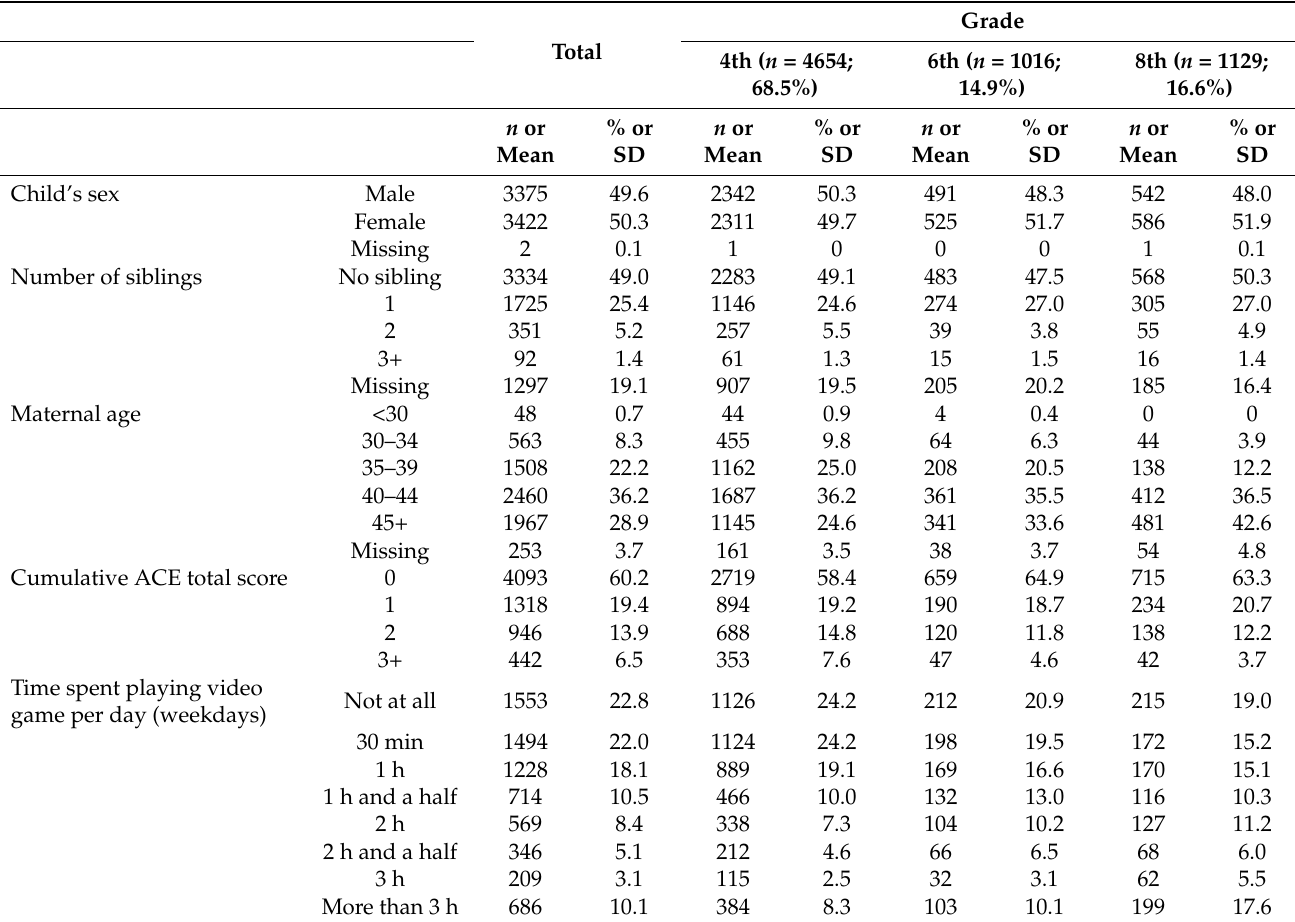
Table 1. Characteristics of the sample ( n = 6799).